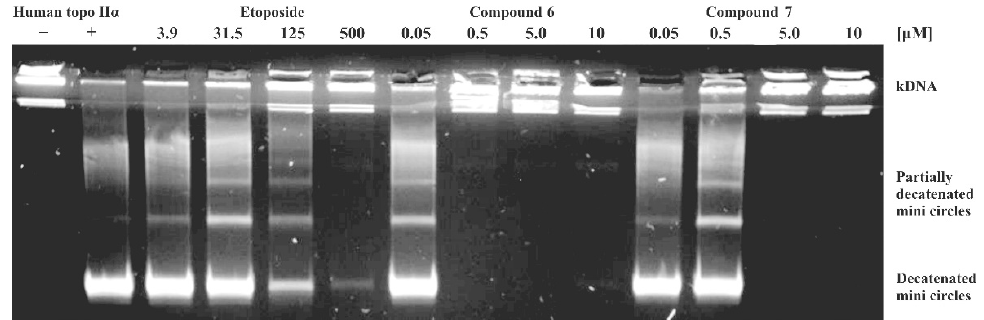
Figure 4. Results of the human topo II α decatenation assay. The assay was performed at four different concentrations of compounds 6 and 7 (0.05, 0.5, 5.0, and 10 µM), and of etoposide as positive control (3.9, 31.5, 125, and 500 µM).